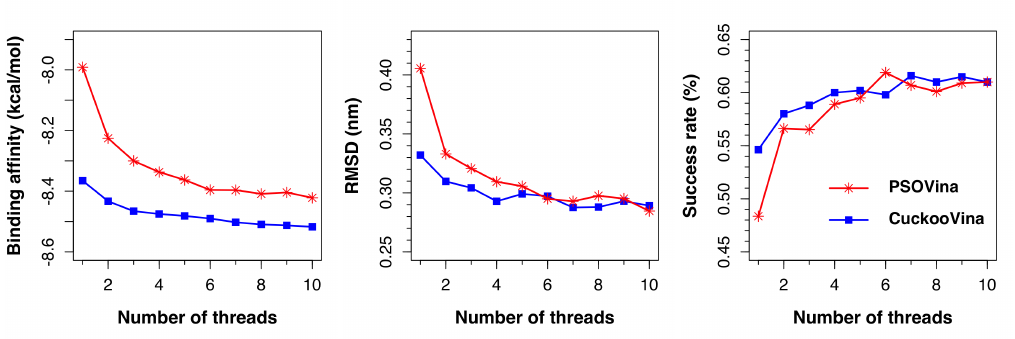
Figure 6. Effect of the number of threads on the docking performances of PSOVina and CuckooVina using the PDBbind2012